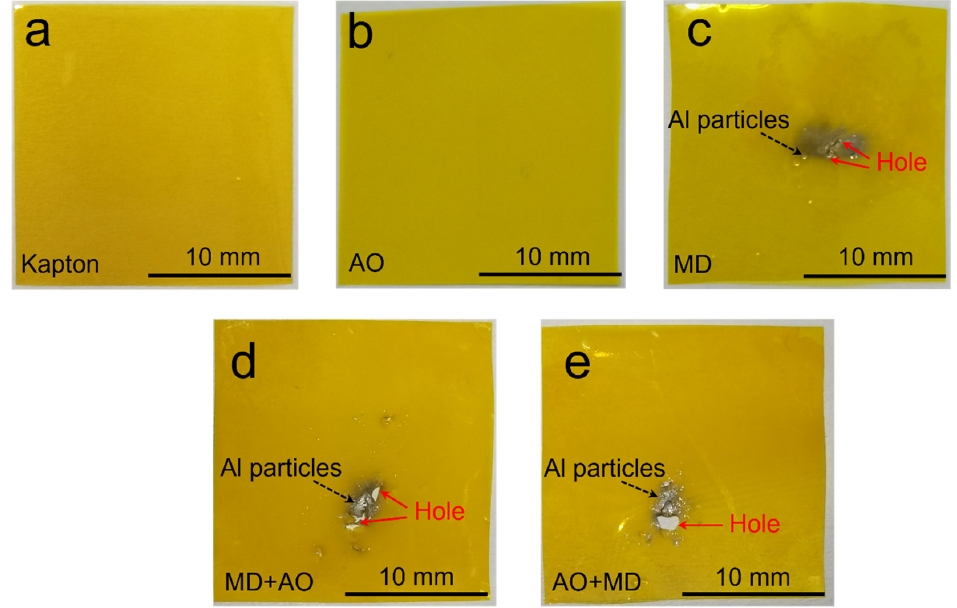
Figure 4. Macro images of Kapton film: ( a , × 2) original film; ( b , × 2) film after AO load spectrum test; ( c , × 2) film after MD load spectrum; ( d , × 2) film after MD + AO load spectrum test; ( e , × 2) film after AO + MD load spectrum test.